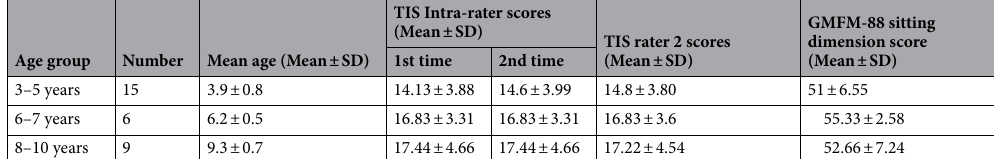
Table 2. TIS values, sitting dimension GMFM-88 scores according to age groups. TIS: Trunk Impairment Scale, SD: Standard Deviation, GMFM: Gross Motor Function